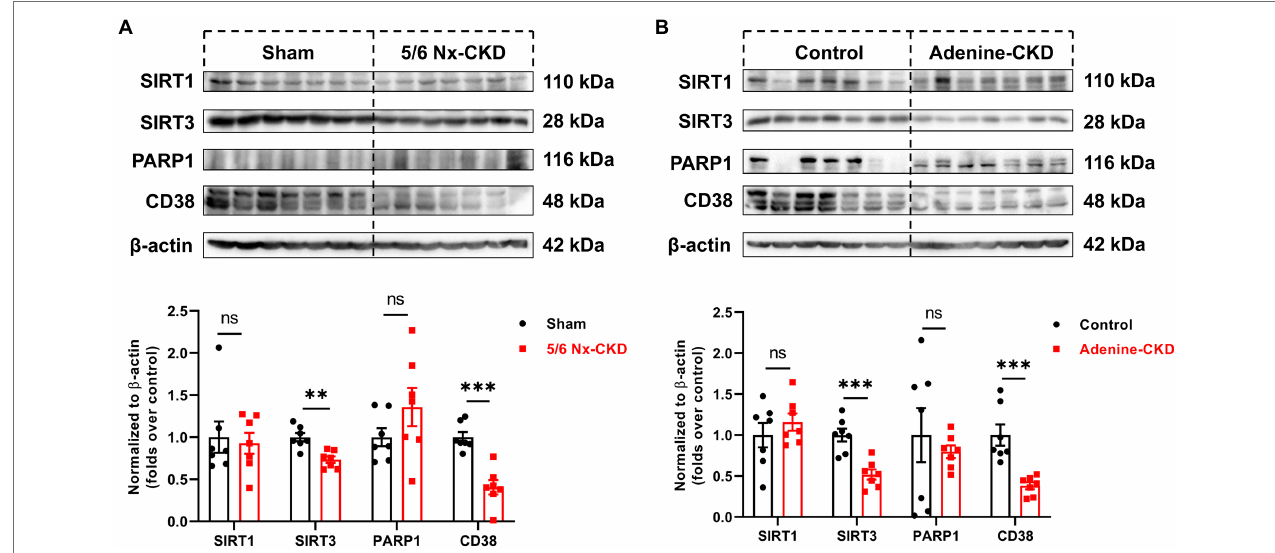
FIGURE 5 | The protein expression of NAD + -consuming enzymes. (A) Representative Western blot images and densitometric analysis of SIRT1, SIRT3, PARP1, and CD38 in the kidney of sham and 5/6 Nx-induced CKD rats. (B) Representative Western blot images and densitometric analysis of SIRT1, SIRT3, PARP1, and CD38 in the kidney of control and adenine-induced CKD rats. Data are presented as the means ± SEM, n = 7 rats per group ( ** p < 0.01 and *** p < 0.001 between the indicated two groups).